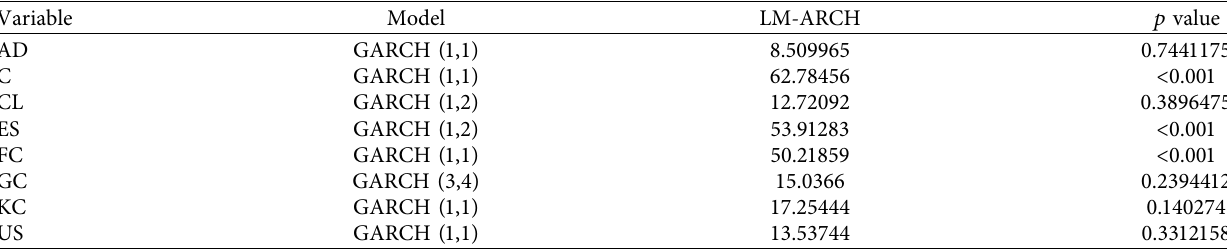
Table 7: LM test for autoregressive conditional heteroscedasticity.